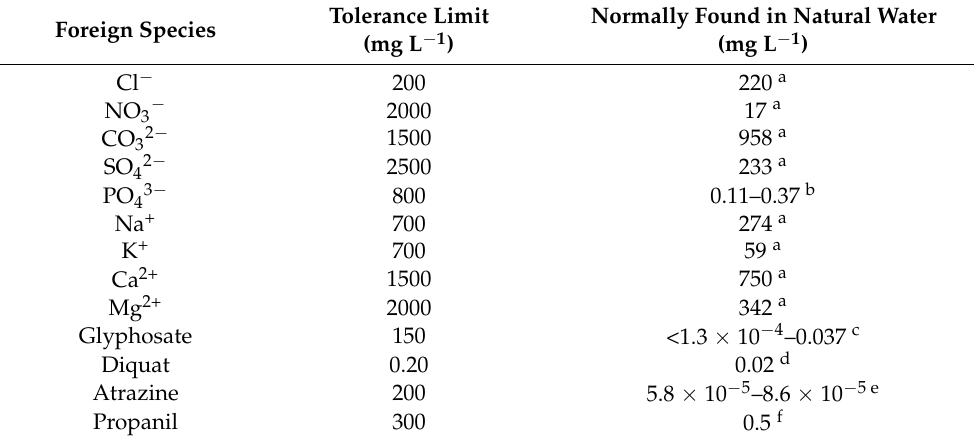
Table 2. Tolerance limit of some interferences on determination of 1.0 mg L − 1 paraquat.